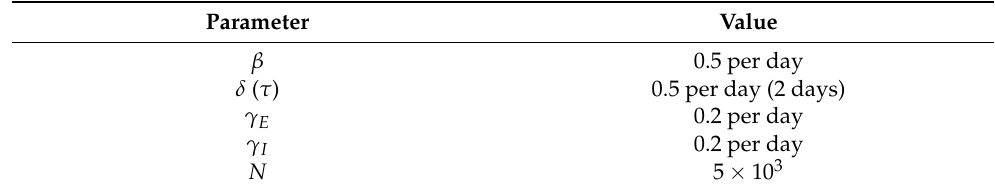
Table 1. Parameter values for delayed stochastic epidemic model (1). The fixed delay in exposed stage is 2